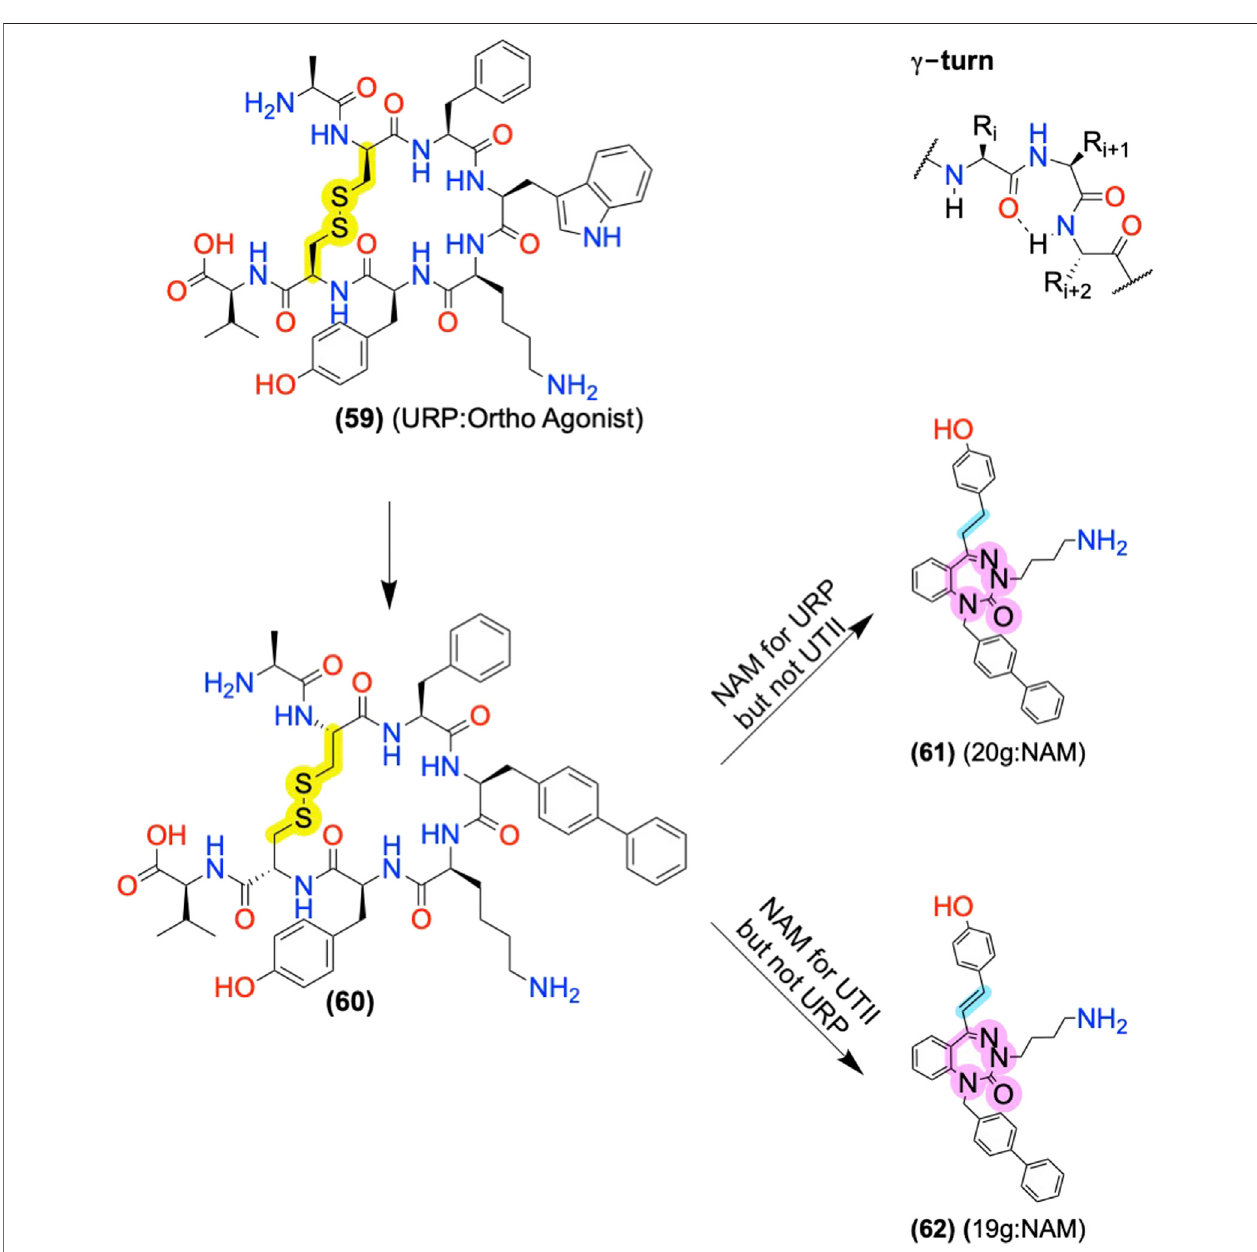
FIGURE 13 | Global restraints and scaffold replacement to identify probe-dependent AMs at UTII. The disul fi de bond stabilizes the γ -turn. Substitution of peptide backbonethatretainedkeypharmacophoreelementsledtoprobe-dependentNAMsforeitherendogenousorthostericagonist,URPorUTII.Cyanhighlights “ sidechain ” differencesbetween (61) and (62) .Theyellowhighlightsshowastructuraldifferencethatleadstoprobedependence.Thein-textcompoundnumberisbold,followedby original name: activity. Structures were originally reported by Chatenet et al., 2013; Dufour-Gallant et al., 2015; and Douchez et al., 2017. Figure was created with